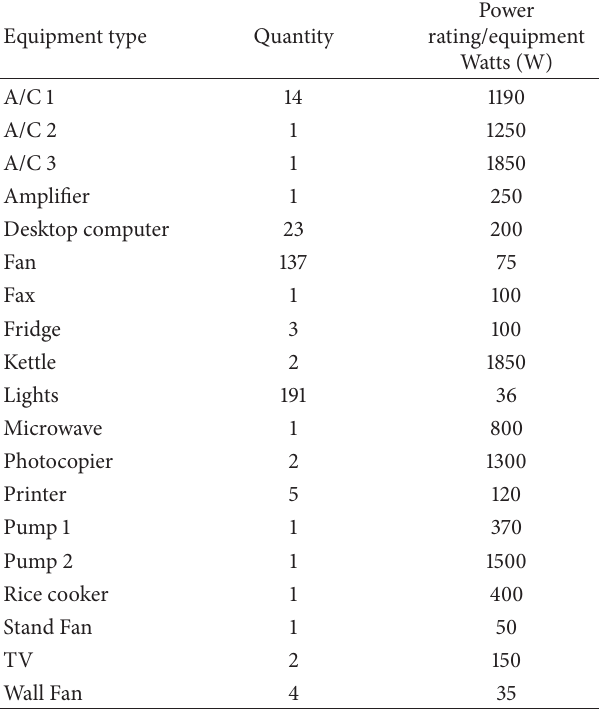
Table 2: List of electrical equipment in the school. Equipment type